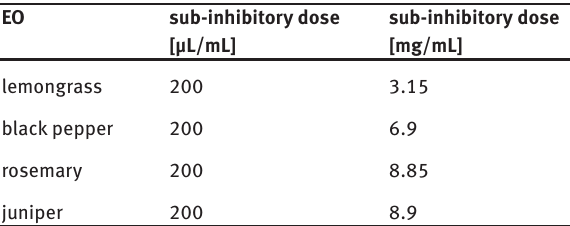
Table 1: The sub-inhibition concentrations of tested Eos.